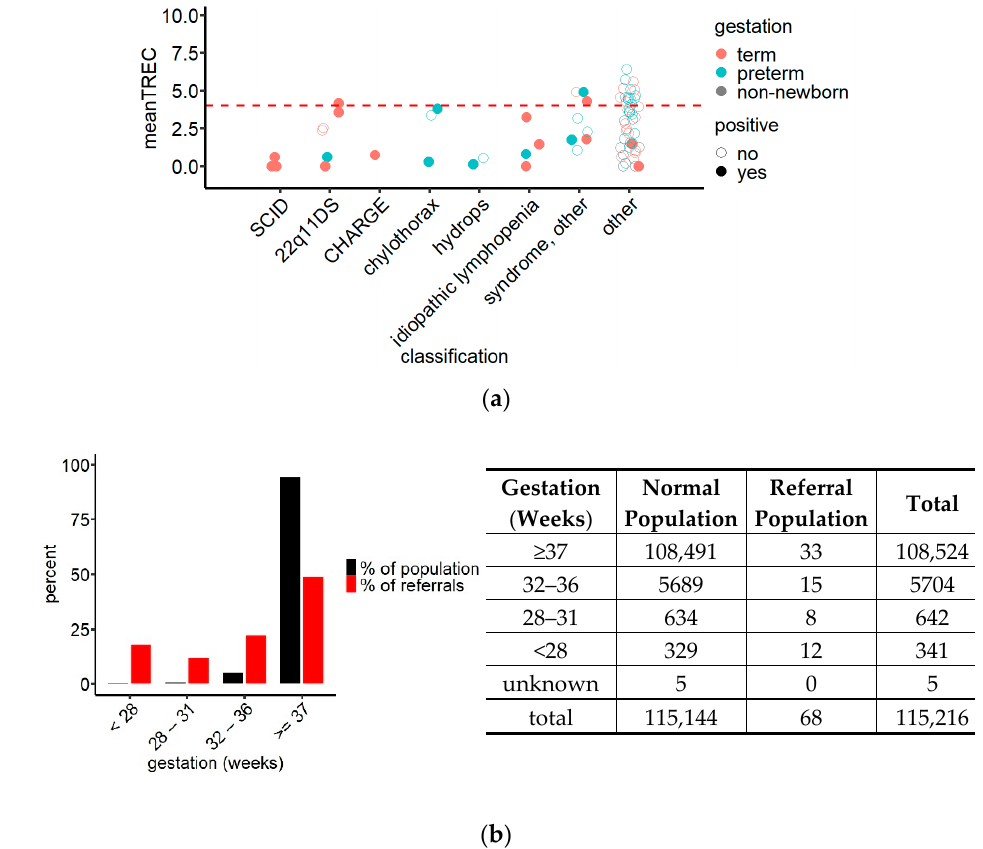
Figure 4. ( a ) TREC values of referrals grouped by clinical diagnosis and gestational age demonstrating the accumulation of the TREC values of TP (SCID and non-SCID lymphopenia, filled circles) in the lower half of the referral interval while the TREC values of FP (non-lymphopenic children, empty circles) were spread throughout the entire referral interval. Red dashed line = hypothetical referral cut-off at TREC 4 copies/well. N = 73; ( b ) comparison of the contribution of gestational age groups to the screened newborn population and to the referrals (left) and crosstabulation of the data underlying the statistical analysis (right) revealing an overrepresentation of preterm children in the referred population (red) compared to their frequency in the screened population (black); chi-squared test, x 2 = 900.75, df = 4, p < 0.0001.